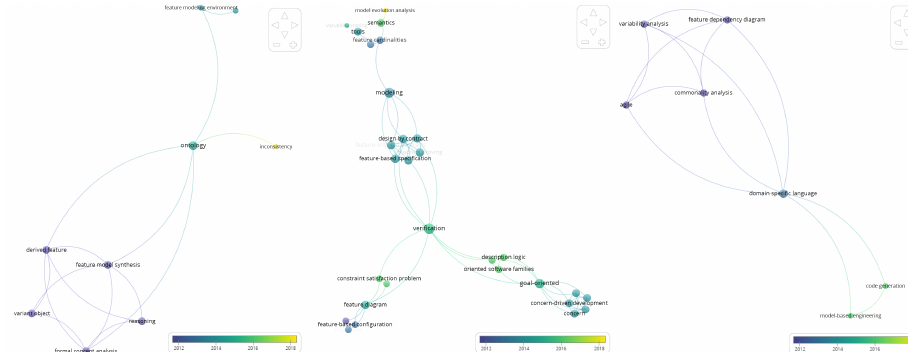
Figure 24. Details of three clusters from relevant terms.